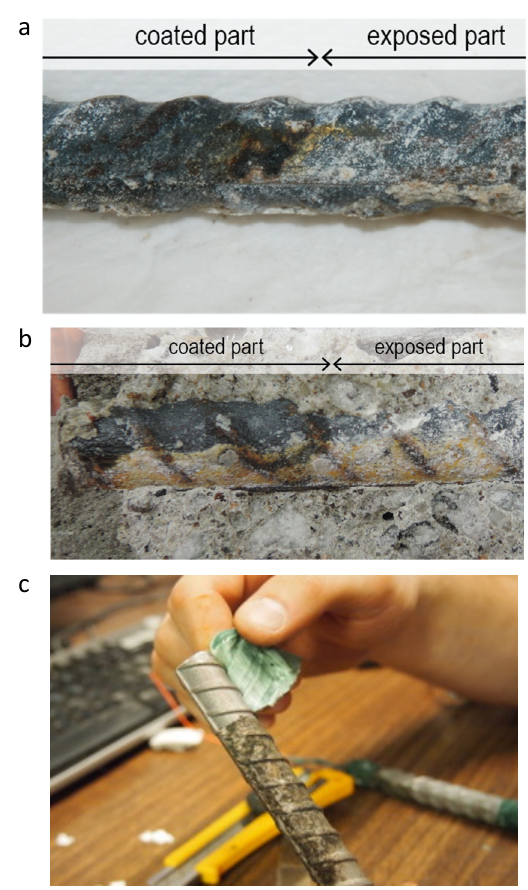
Figure 2: Crevice corrosion under rebar end coating (a) extracted rebar, (b) rebar in concrete. (Coating was removed before photographs were taken), (c) UNS 24100 stainless steel rebar after removal from chloride contaminated concrete and removal of the lacquer and shrink‐fit end coating illustrating the absence of crevice corrosion. (Photos in (a) and (b) are the courtesy of U. Angst; photo in (c) is the courtesy of P.